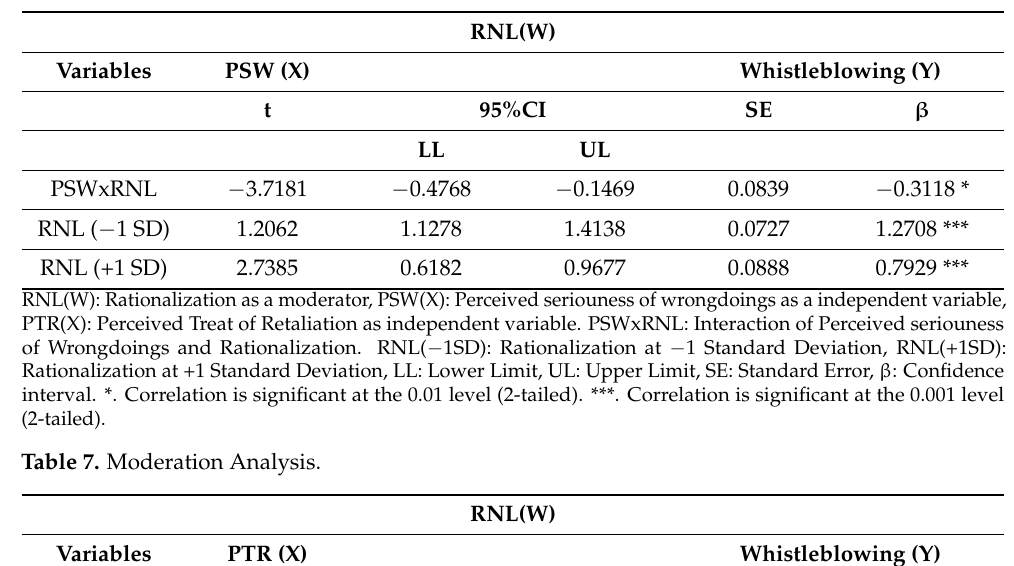
Table 6. Moderation Analysis.